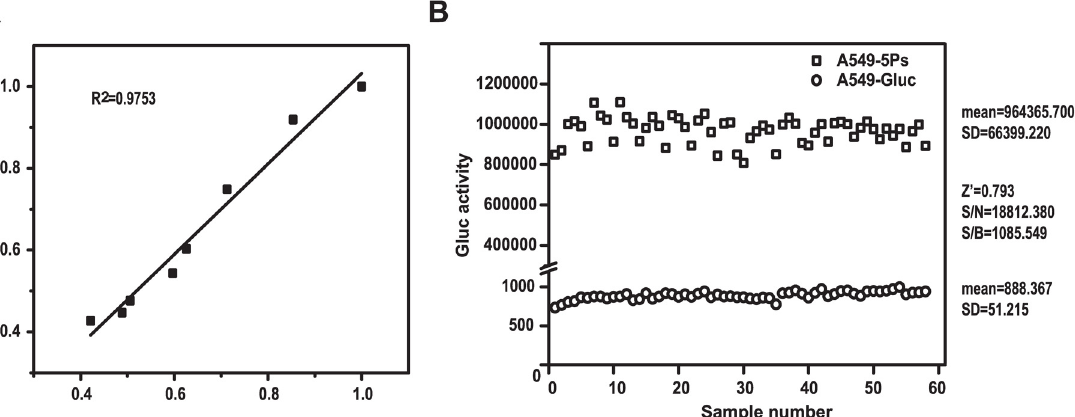
Fig 6. Validation of a HTS assay for IAV transcription/replication inhibitors. (A) Determination of R 2 value. A549-5Ps cells were treated with various concentration of ribavirin for 72 hours, followed by Gluc activity analysis. R 2 was calculated in two independent experiments (each experiment was triplicates). (B) Determination of parameters for the screening assay. A549-5Ps and A549-Gluc cells were seeded into 96-well plates (1×10 4 /well) and cultured for 72h hours. Supernatants were harvested to measure Gluc activity. Z ’ factor, signal-to-noise ratio (S/N) and signal-to-background ratio (S/B) were calculated using the following equations: Z ’ = 1 − 3×(SD of A549-5Ps + SD of A549-Gluc)/(mean of A549-5Ps − mean of A549-Gluc); S/N = (mean of A549- 5Ps − mean of A549-Gluc)/SD of A549-Gluc; S/B = mean of A549-5Ps/mean of A549-Gluc.